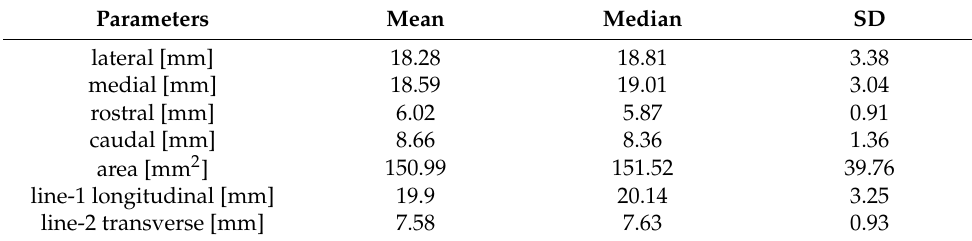
Table 1. The descriptive analysis of obtained results in the whole